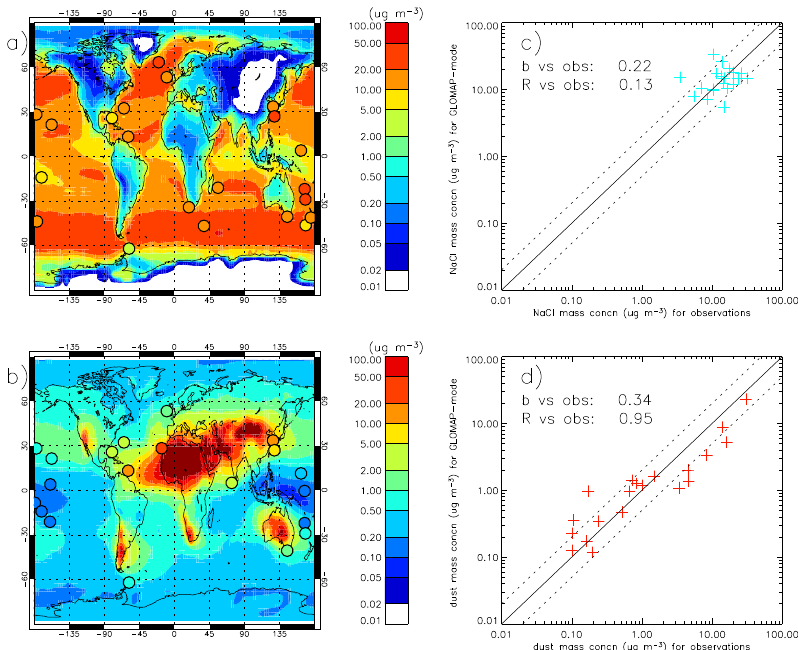
Fig. 8. Global maps of simulated annual-mean mass concentration in the lowest model level of (a) sea-salt and (b) dust with surface observations from University of Miami sites over-plotted. Scatter plots for the model (y-axis) compared to the observations (x-axis) are shown in panels (c) and (d) with b and R values also